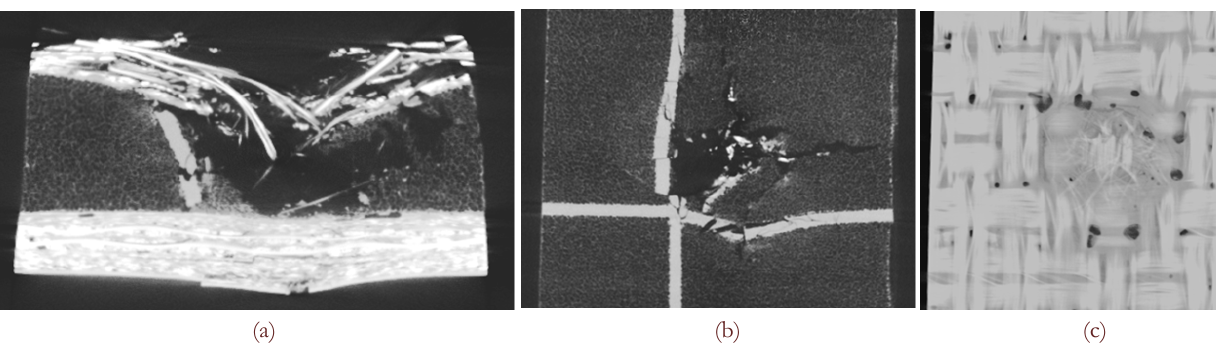
Figure 14: Tomograms of GFRP-PVC foam core panel after the impact (v = 7 m/s); the ply in (c) is on the lower skin of the sample.